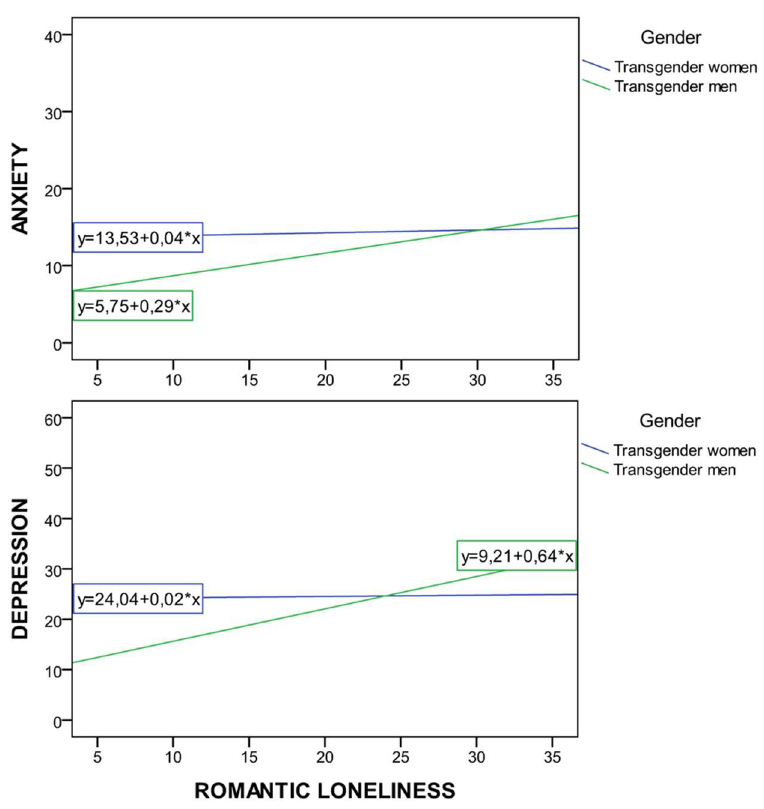
Figure 1. Romantic loneliness × gender interaction effect on mental health: ( a ) Depression; ( b ) Anxiety.